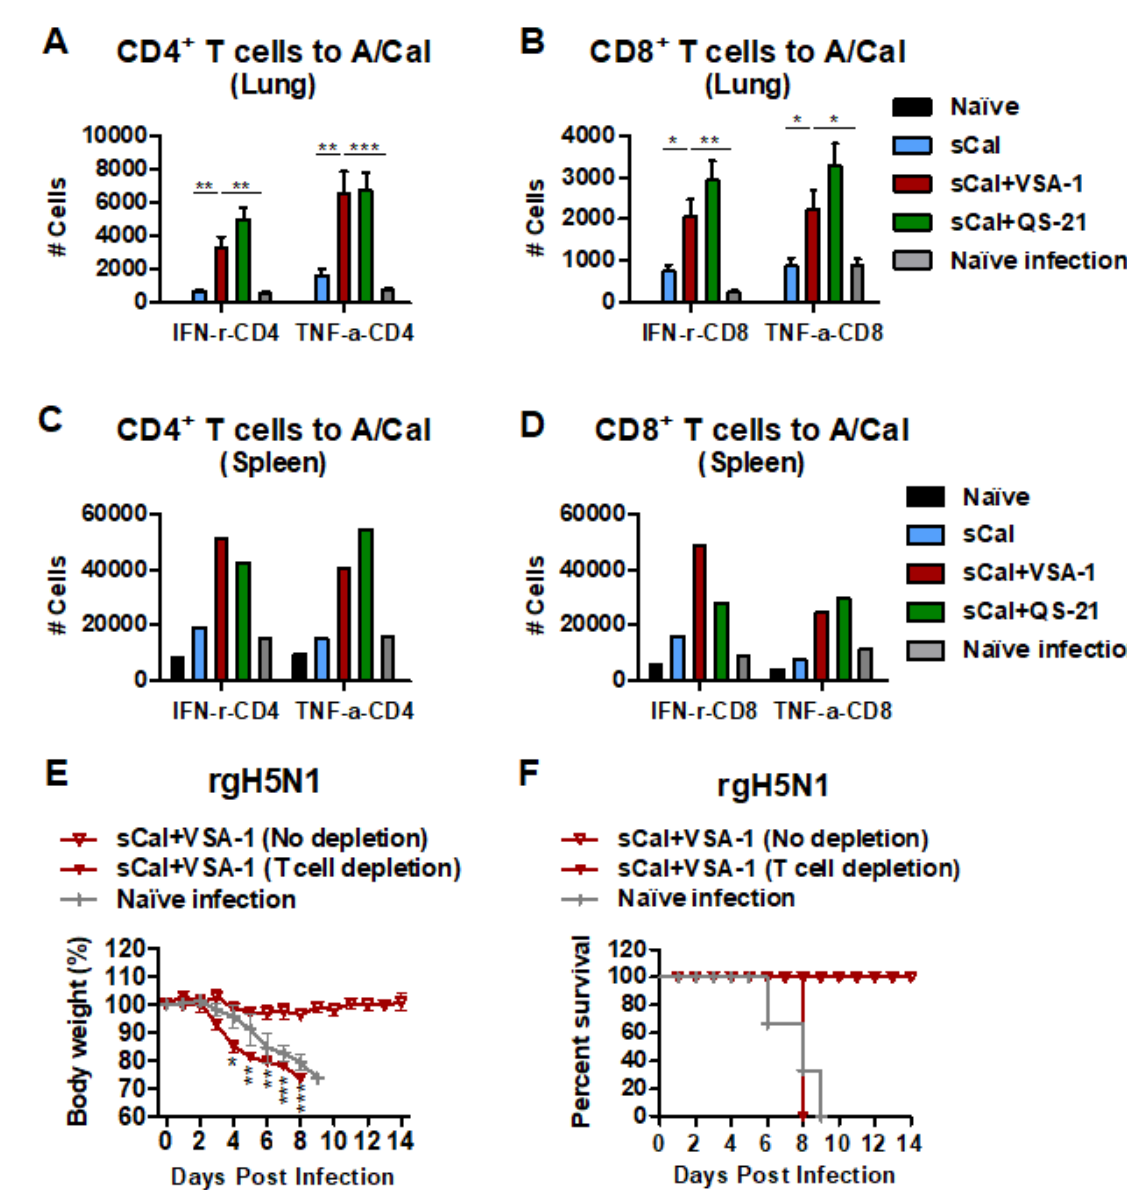
Figure 7. VSA-1-adjuvanted sCal vaccination confers T cell-mediated protection against rgH5N1 virus. ( A – D ) Flow cytometry data of IFN- γ -secreting CD4 + and CD8 + T cells in ( A , B ) lung and ( C , D ) spleen samples. ( E ) Body weight changes and ( F ) survival rates in VSA-1-adjuvanted prime-boost-immunized C57BL/6 mice ( n = 3) with CD4 and CD8 T cells depleted and rgH5N1 virus challenge. Error bars indicate the mean ± SEM. *; p < 0.05, **; p < 0.01, ***; p < 0.001 compared to the sCal + VSA-1 group.